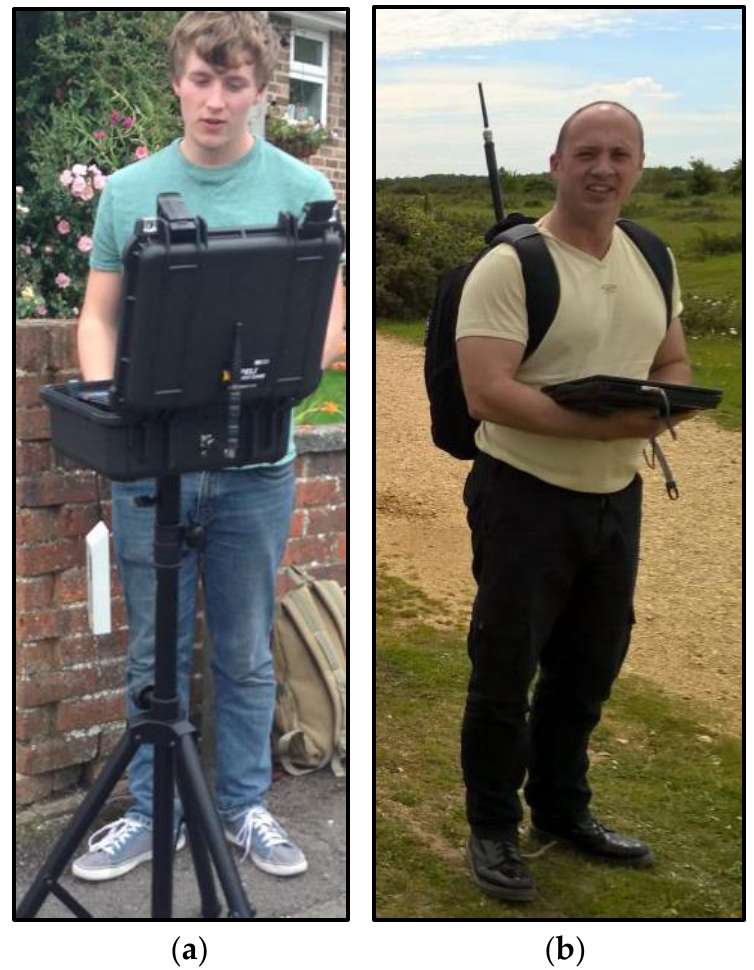
Figure 1. ( a ) Mesh transmitter setup; ( b ) mesh receiver setup.